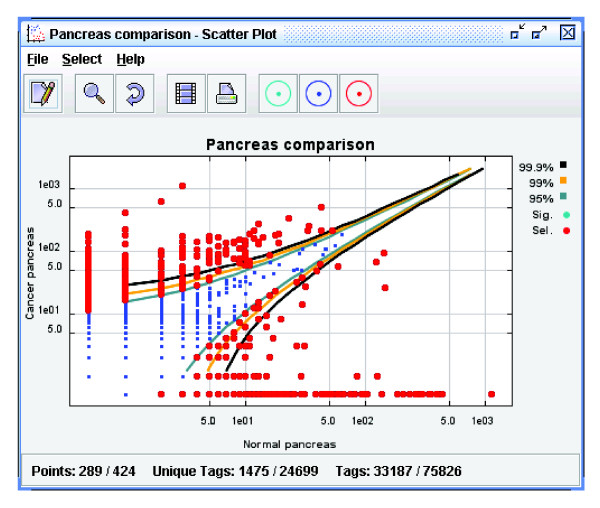
A screenshot of the DiscoverySpace Scatterplot. To use the Scatterplot the user must define a comparison between two sets of tag sequences. For this example the researcher has constructed a comparison of one normal pancreas library on the x-axis versus two cancer libraries on the y-axis. This comparison has then been viewed in the Scatterplot and the researcher has selected those tags that are up- and down-regulated with a confidence threshold of 95% or greater (marked in red). Selected tags can be dragged out of the chart and isolated into their own dataset 'Up & down regulated pancreas' for further investigation.